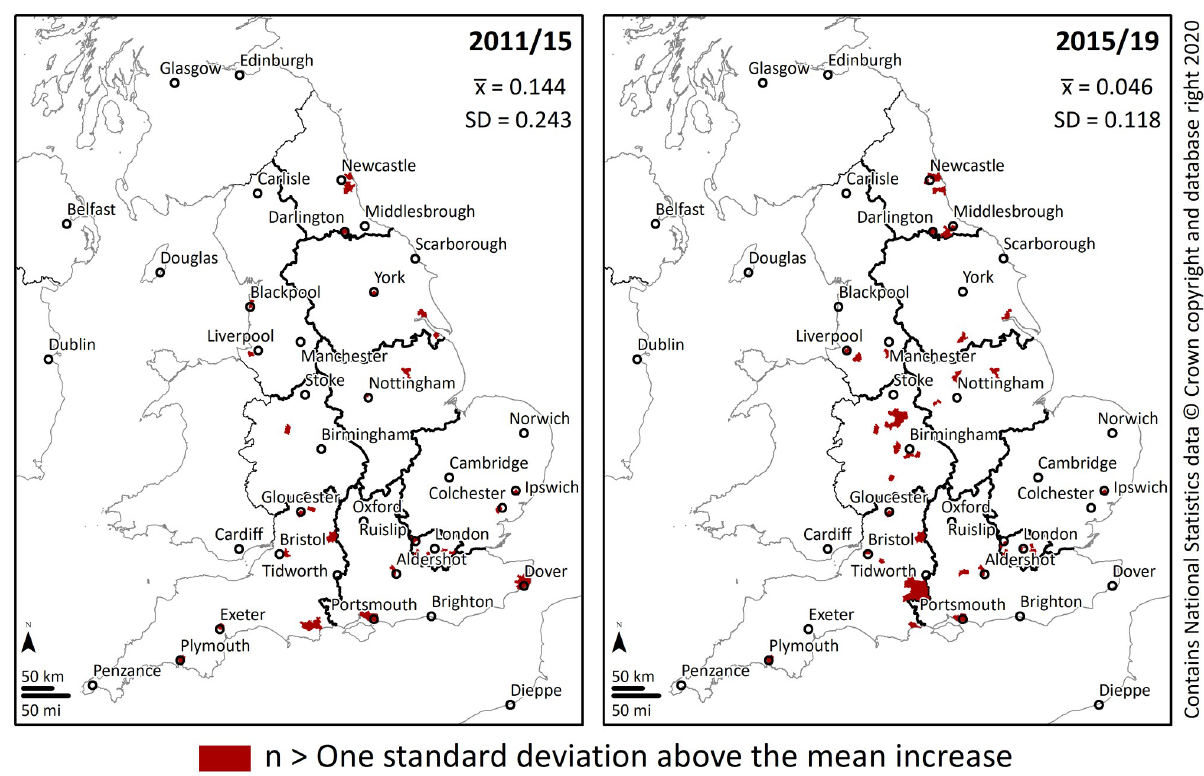
Fig 5. Constituencies with a change in the density of SSP pupils greater than one standard deviation above the mean increase.